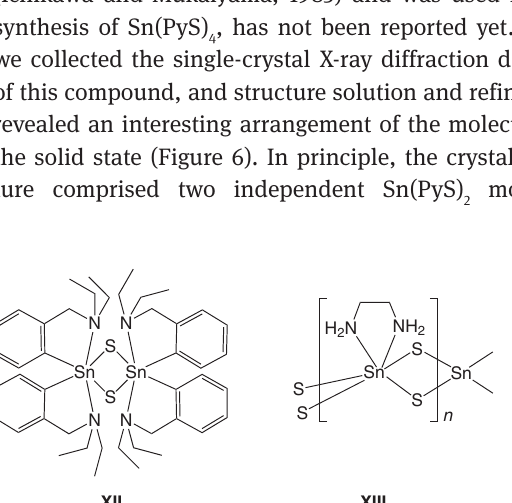
Figure 4 29 Si CP/MAS NMR spectrum of Cl Signal traces are as follows (from top): simulated signal with smoothing (red), experimental spectrum (blue), and simulated signal as stick approximation without smoothing (green).